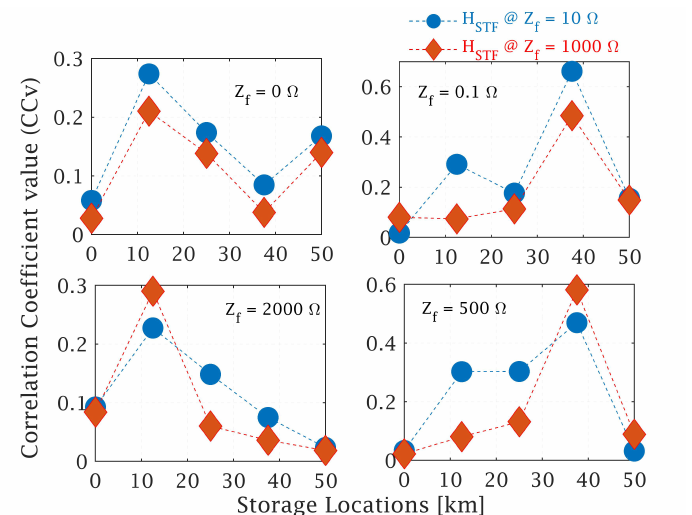
Figure 20. Correlation of low- and high-impedance fault— H STF with H fos due to x f = 10 km with Z f = 0 Ω and 2000 Ω ( left column ) and with H fos due to x f = 35 km with Z f = 0.1 Ω and 500 Ω ( right column ).